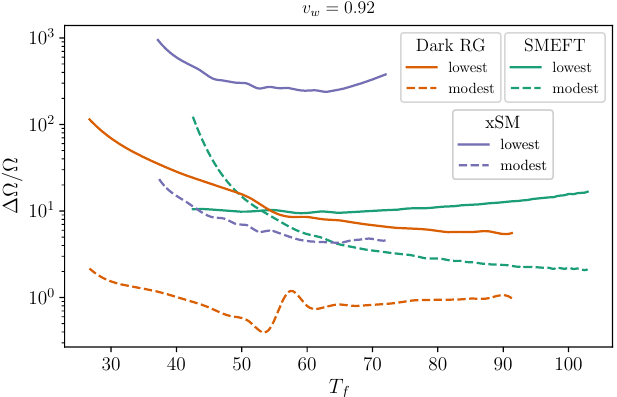
Figure 2 . The relative error when using the lowest and modest levels of diligence, compared to the highest level of diligence (for which ∆Ω / Ω = 0 ). The vertical axis shows the peak (frequency- independent) gravitational wave energy density for detonation. The precise definition of ∆Ω / Ω is given in eq. (4.1). The horizontal axis corresponds to the final temperature T when the phase tran- f sition ends. Three models are shown: SMEFT, a dark sector Higgs model (Dark RG) and the singlet- extended Standard Model (xSM). The figures employ calculations from eq. [(2.7), (2.15), (2.61)] and eq. (4.1). The temperatures are set to T (2.4), T (2.11), and T (2.27) for the lowest, mod- n p f est, and highest diligence respectively. Both the modest and highest diligence contain suppression factors due to the lifetime of the source. The highest diligence contains the suppression factor due to vorticity effects in the